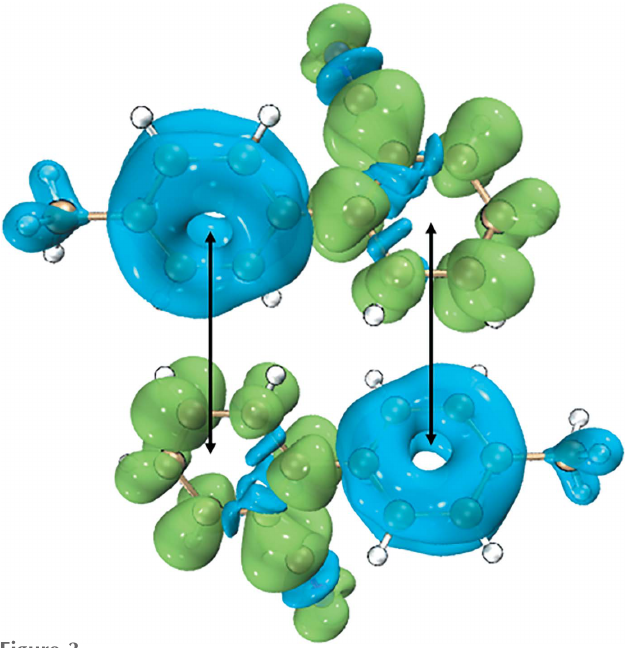
Figure 3 Orbital-weighted dual descriptor isosurface of OTBN